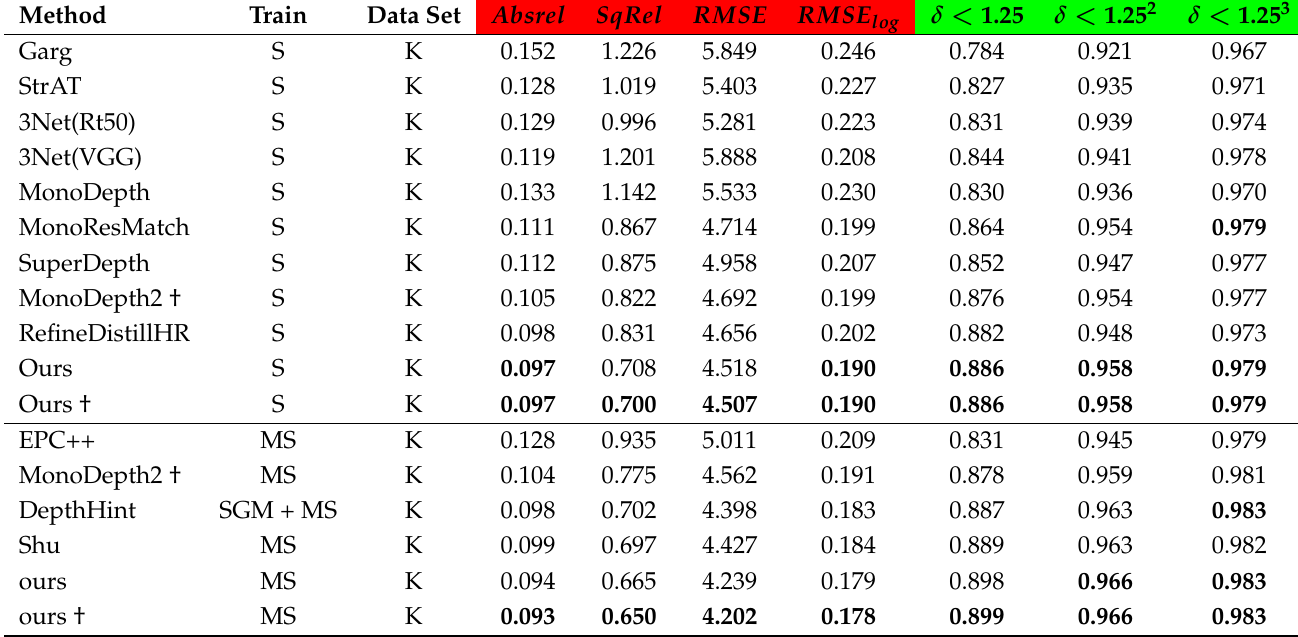
Table 1. Comparison of performance on the original KITII Eigen Split. The best results are in bold. S, trained on stereo pairs; MS, trained on calibrated binocular videos; †, trained using post processing steps. The metric in red is better. The metric in green is